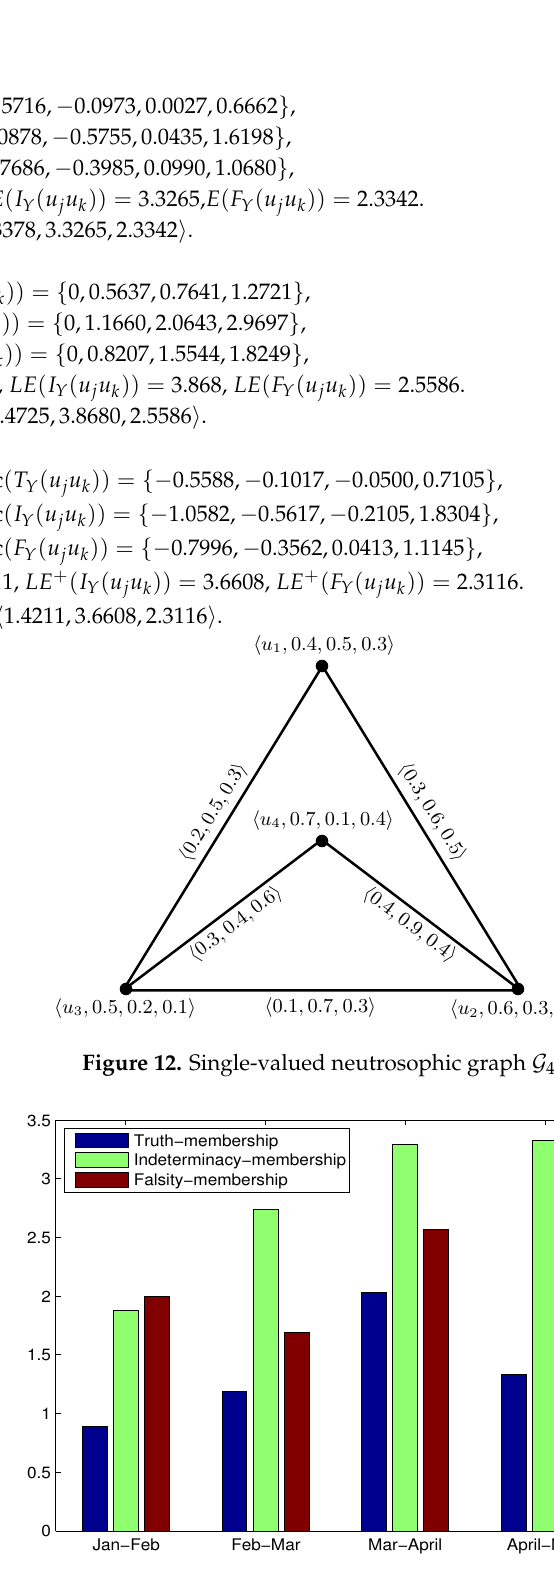
Figure 13. Energy of single-valued neutrosophic